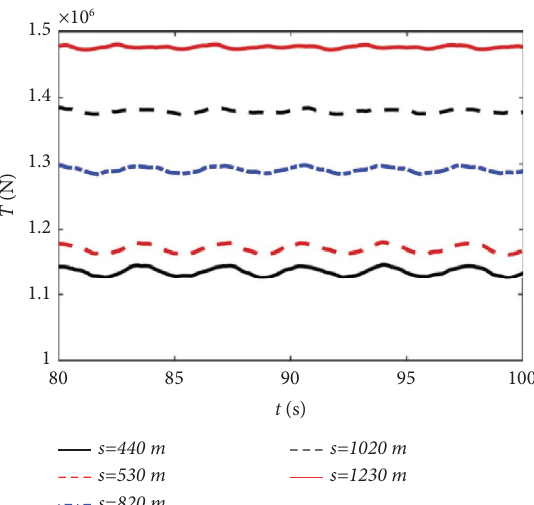
Figure 19: Time history of normal